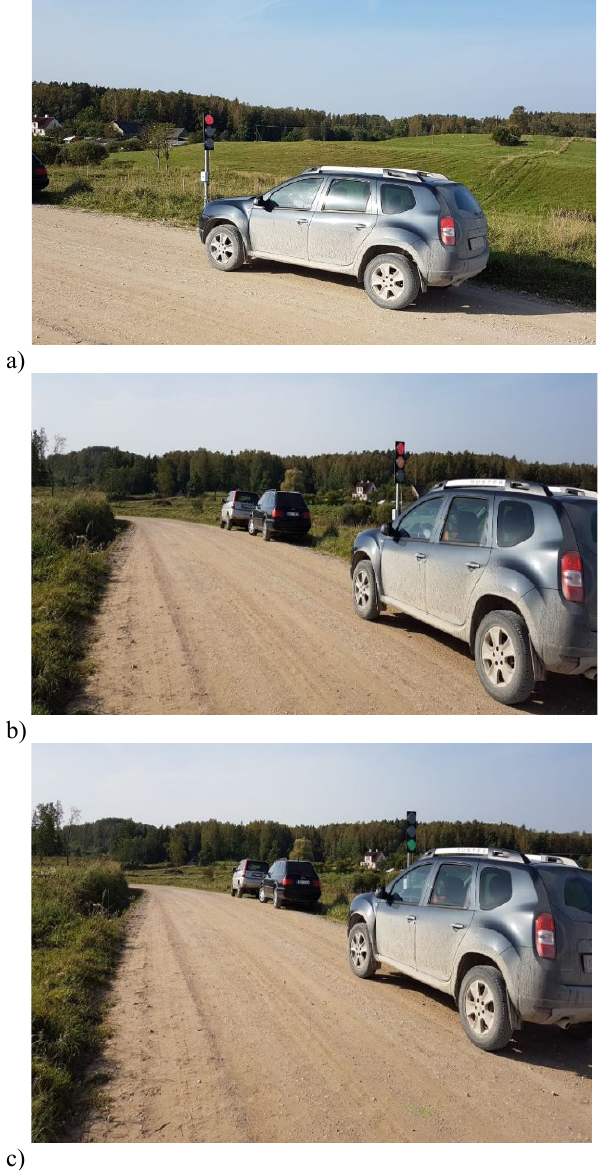
Fig. 12. Traffic light operation testing in the real